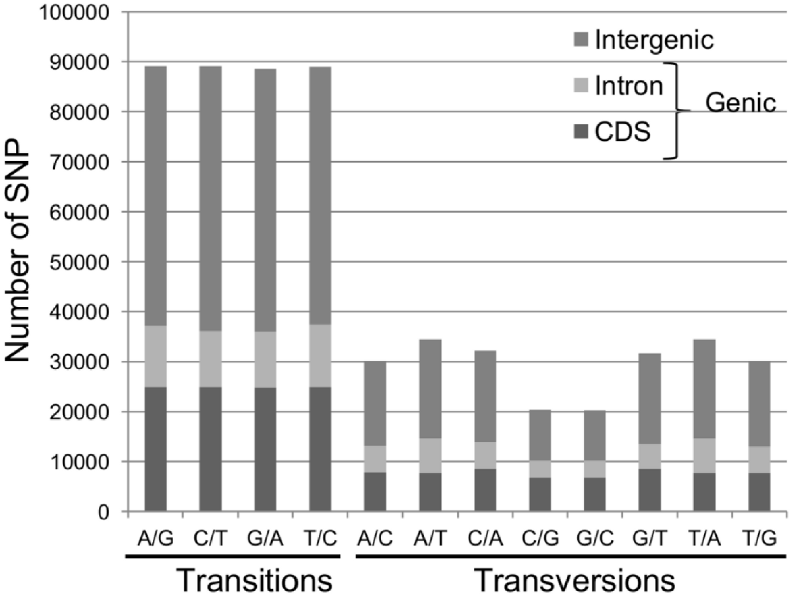
Figure 2. Filtered SNP types and their classification according to genomic regions. Transition and transversion SNP types were classified to show the proportion of SNPs annotated to each of three genomic regions (Intergenic, Intron, and CDS). CDS: coding